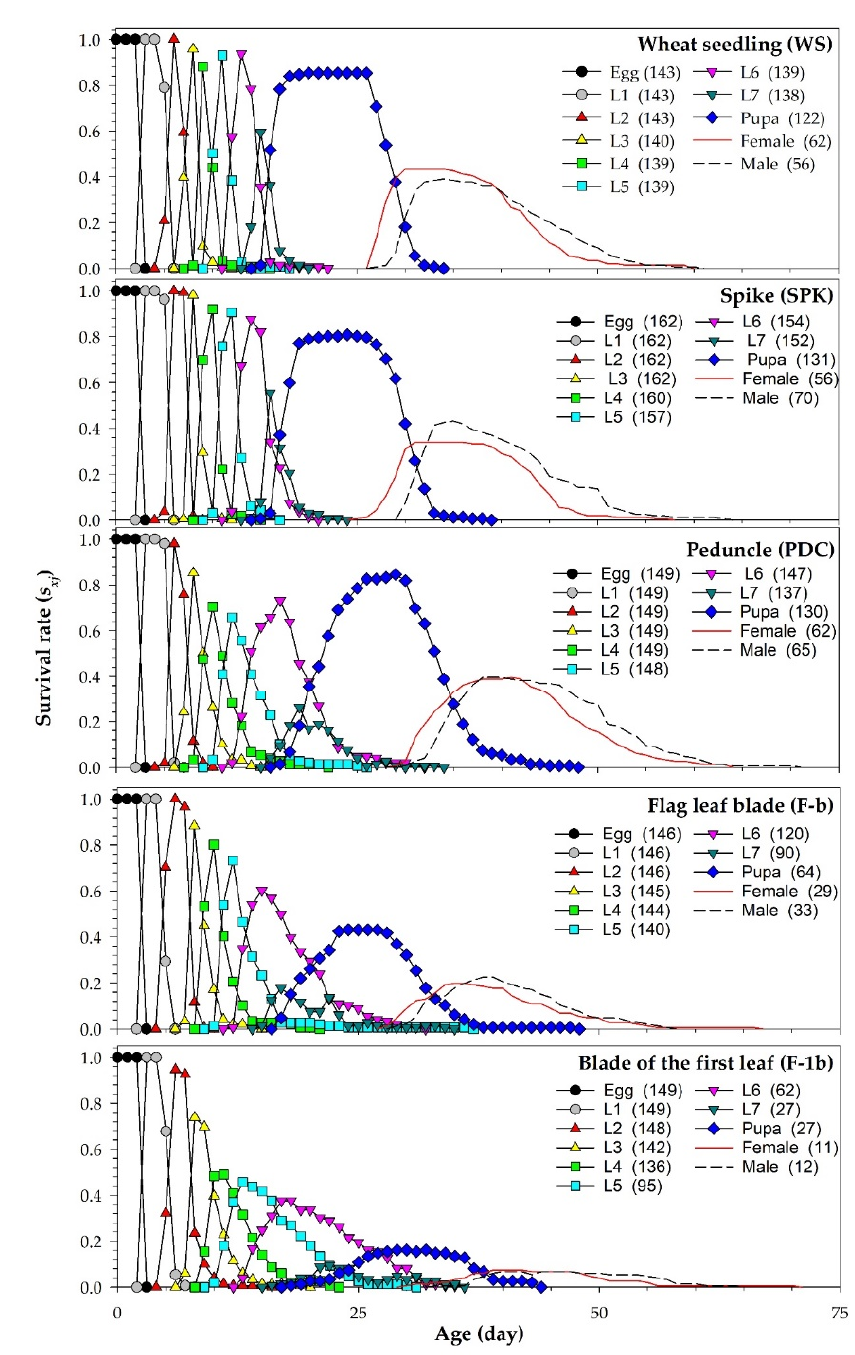
Figure 1. Age-stage specific survival rate ( s xj ) of the FAW fed on different wheat tissues in the laboratory. Numbers in the bracket after each stage represent the number of individuals developed to that stage.